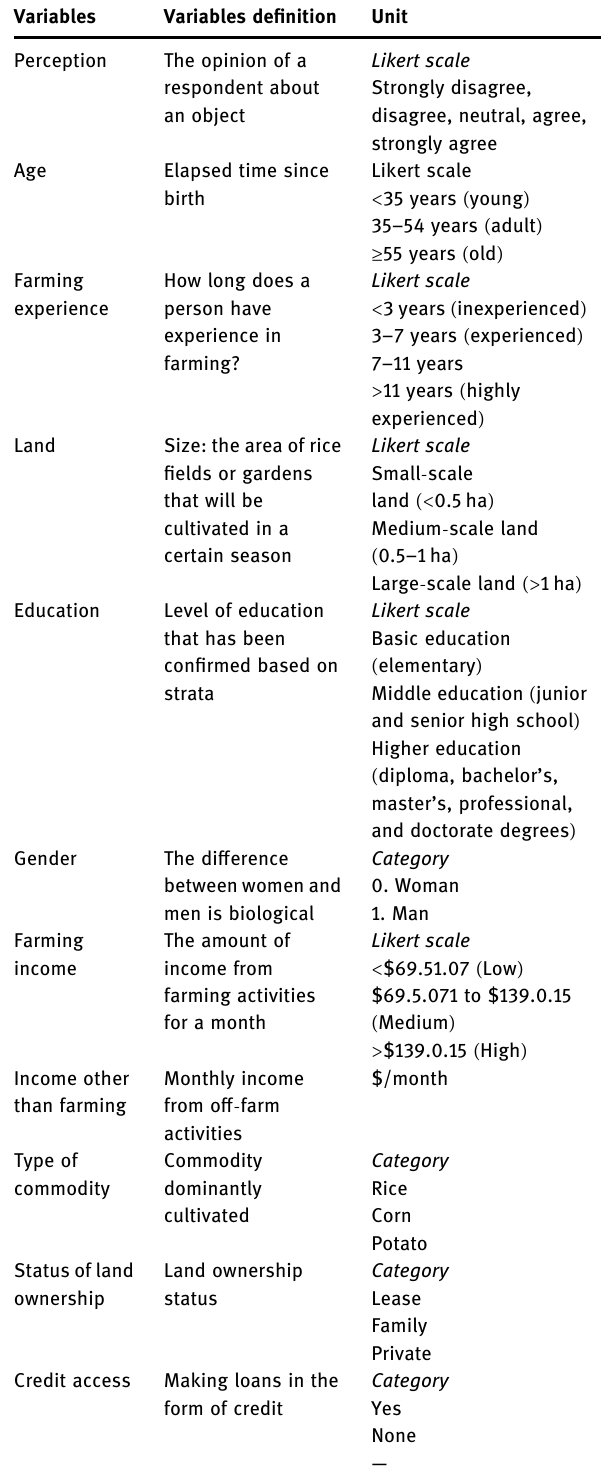
Table 1: Variables in the research questionnaire Variables